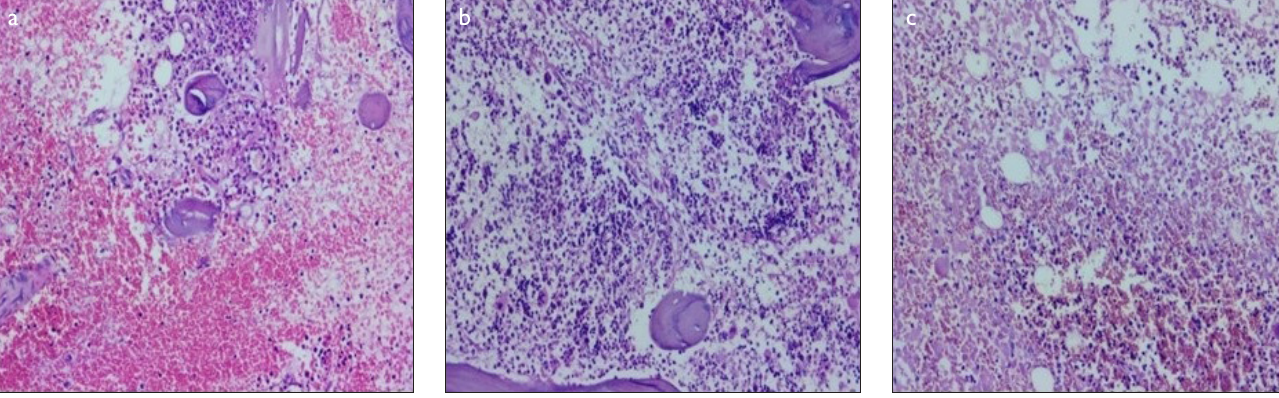
Figure 4. a-c. Hematoxylin-eosin staining of bone marrow necrosis (10x magnification). (a) Saline, (b) 0.5% NaOCl, and (c) 5%